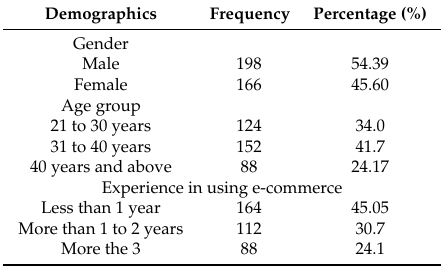
Table 5. Demographic data and respective percentages.